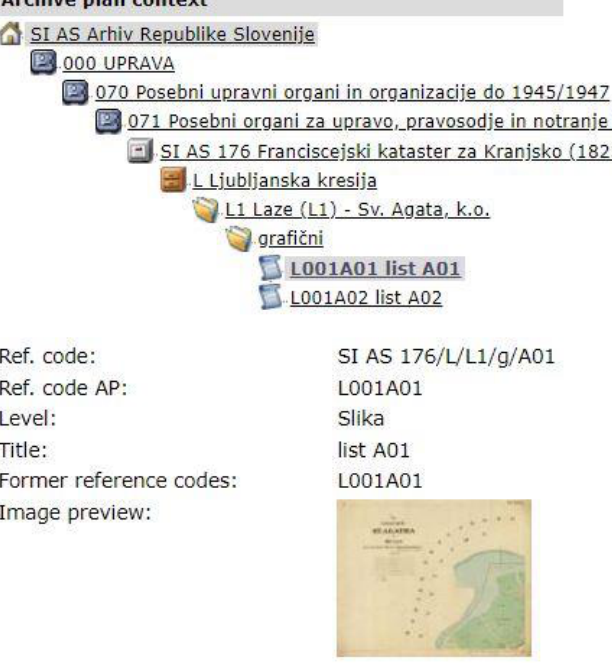
Figure 6. Hierarchical structure in the catalog of ARS and example of ISAD(G) elements for a cadastral map sheet [59].